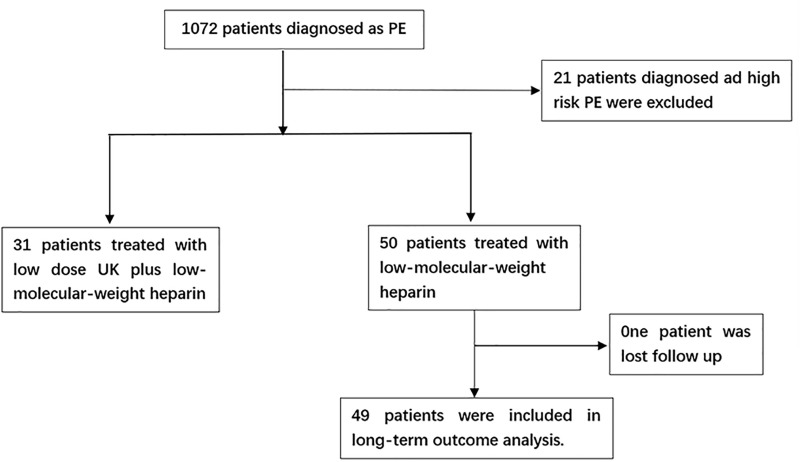
Patient selection process.